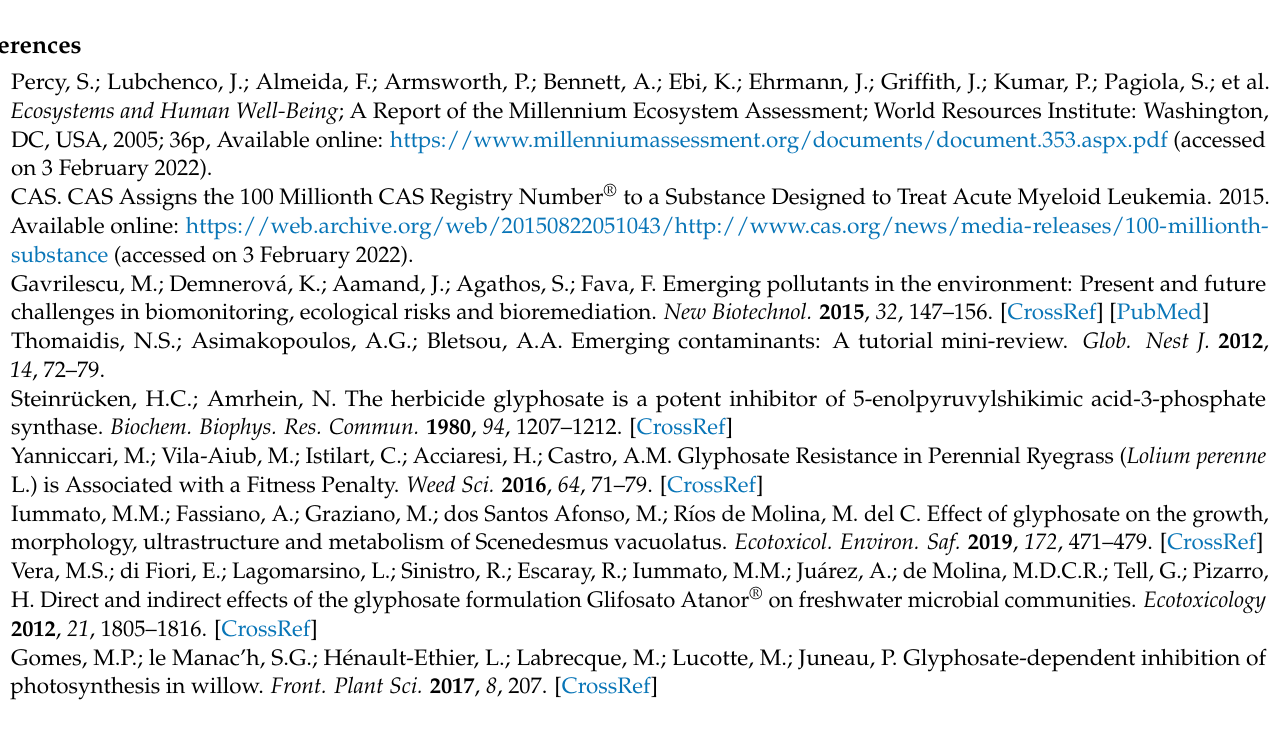
parameters; Figure S2: Lipid peroxidation quantification; Figure S3: Major fatty acids classes; Table S1: Fluorometric analysis parameters and their description; Table S2: Confusion matrix for LDA (Kaut- sky); Table S3: Confusion matrix for LDA